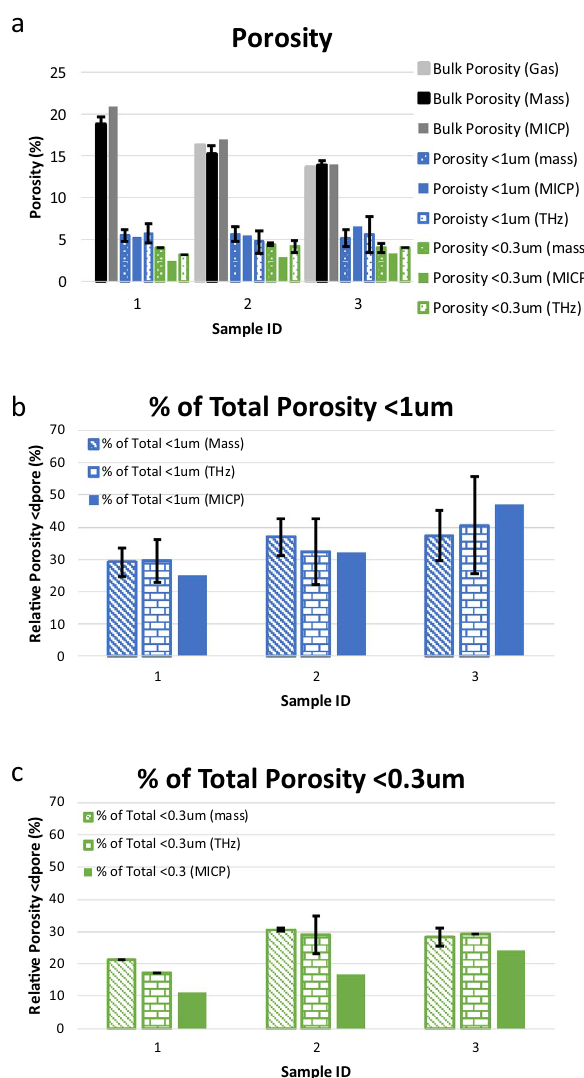
Figure 4. Porosity and microporosity comparisons. ( a ) Total porosity and porosity below each microporosity threshold for Samples 1–3. Total porosity from gas porosimetry (light grey) and MICP (dark grey) are measured on plug and half-plugs of each sample while the total porosity by mass (black) is the average of all measurements on the thin half-moon samples used for THz imaging. The porosity below each microporosity threshold from mass and THz is from the data collected on the half-moon samples and that from MICP is from the half-plug samples (see Fig. 3). THz and mass data are the average of data collected and the error bars represent one standard deviation. ( b , c ) Relative amount of the total porosity attributed to the microporosity (b: d p < 1 µm and c: d p < 0.3